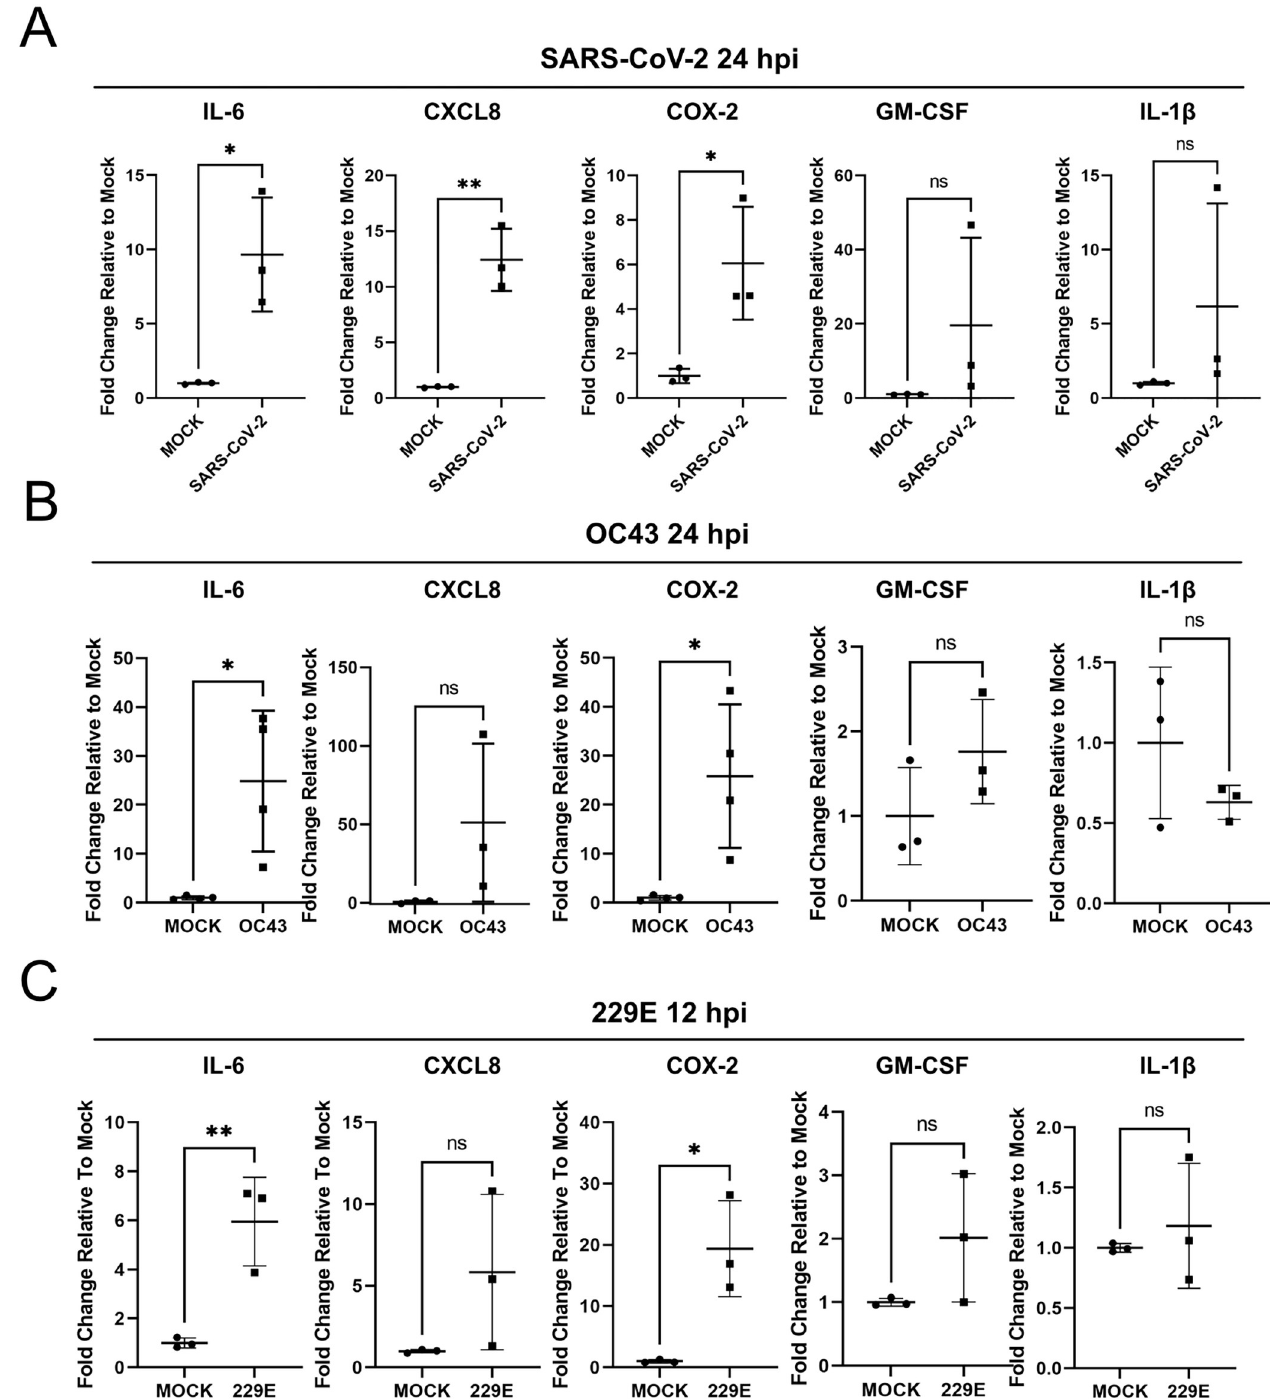
Fig 5. Steady state levels of selected ARE-mRNAs are elevated during coronavirus infection. A. HUVECs were transduced with recombinant lentiviruses expressing human ACE2 (HUVEC ACE2 ), selected, and infected with SARS-CoV-2 TO-1 isolate (MOI = 3). RNA was harvested 24 hours post infection and RT- qPCR was performed using IL-6, CXCL8, COX-2, GM-CSF, IL-1 β and HPRT (house-keeping gene) specific primers. Values are represented as fold change relative to mock-infection. n = 3; mean ± SD ( � , p < 0.05; �� , p < 0.01; ns, nonsignificant). B-C. HUVECs were infected with OC43 (B, TCID 50 /mL = 3.5 x 10 4 ) or 229E (C, TCID 50 /mL = 1 x 10 3.24 ). RNA was harvested 24 and 12 hours post infection for OC43 (B) and 229E (C), respectively, and RT-qPCR was performed as in (A). Values are represented as fold change relative to mock-infection. Statistics were performed using an unpaired Student’s t -test. n � 3; mean ± SD ( � , p < 0.05; �� , p < 0.01; ns, nonsignificant).